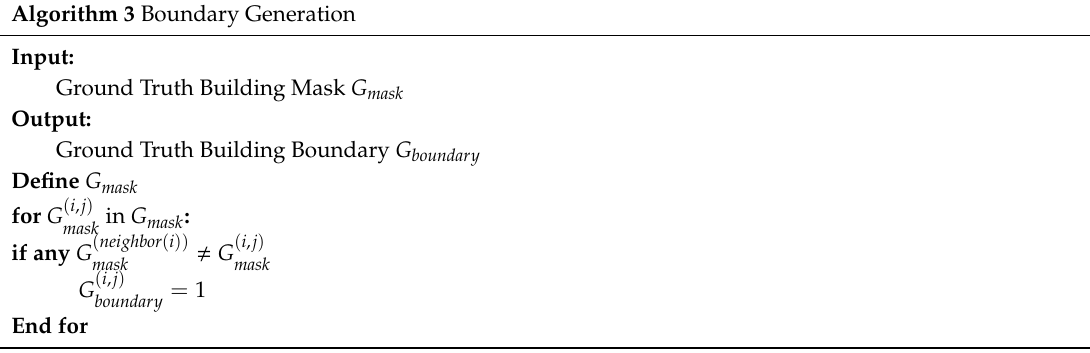
Algorithm 3 Boundary Generation